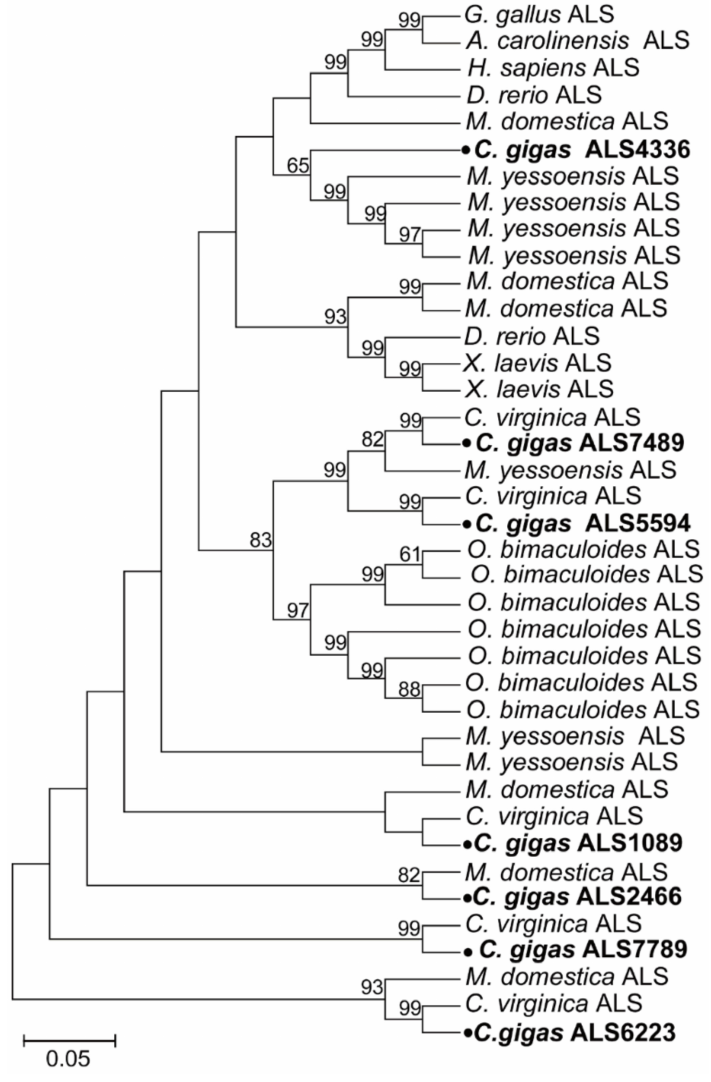
Figure 4. Phylogenetic analyses of the IGF ALSs. The amino acid sequences of the insulin-like growth factor-binding protein complex acid labile subunits from Homo sapiens , Gallus gallus , Xenopus laevis , Anolis carolinensis , Danio rerio , Musca domestica, Mizuhopecten yessoensis , Octopus bimaculoid , Crassostrea virginica, and Crassostrea gigas were retrieved from the NCBI database. The phylogenetic tree was constructed using the neighbor-joining (NJ) approach in MEGA7. The reliability of the topological structure was tested using 1000 bootstrap